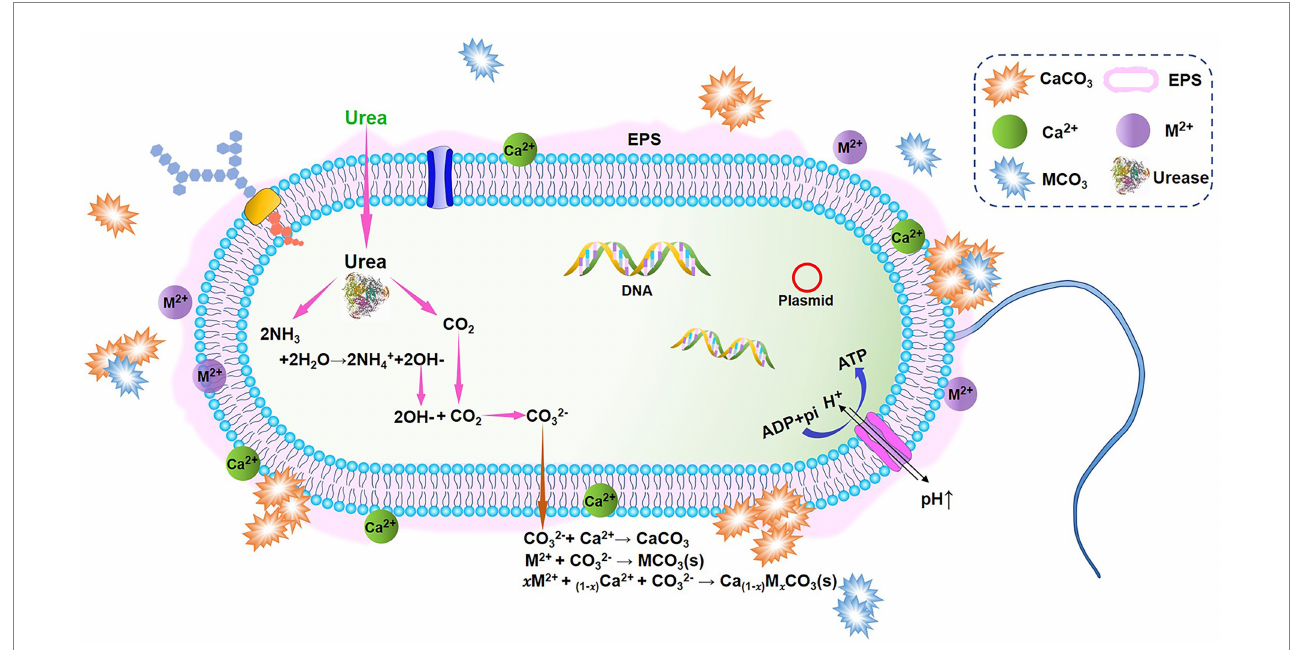
FIGURE 1 A schematic diagram of microbially induced carbonate precipitation (MICP) based on urea hydrolysis. Modified from Song et al.